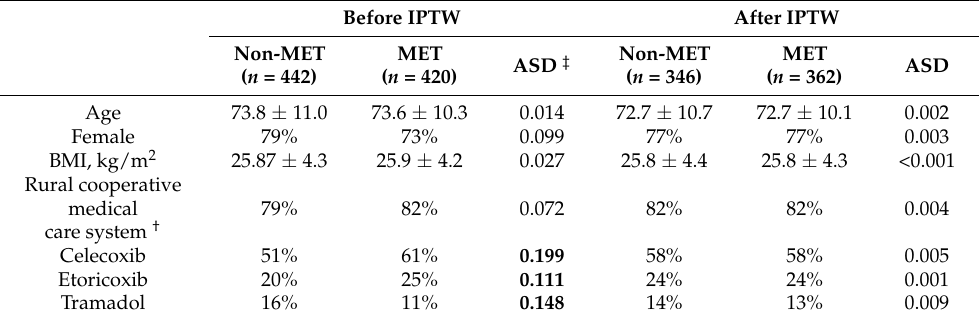
Table 1. Characteristic between metformin users and non-users before and after IPTW using propen- sity score